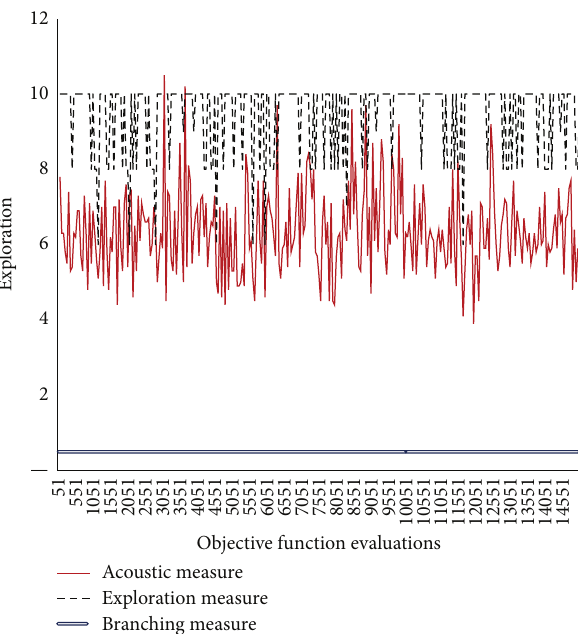
Figure 7: Evaluating ACO ustic against traditional indicators in ACO for the QAP instance kra30a with nearest neighborhood threshold = 𝜖 7.